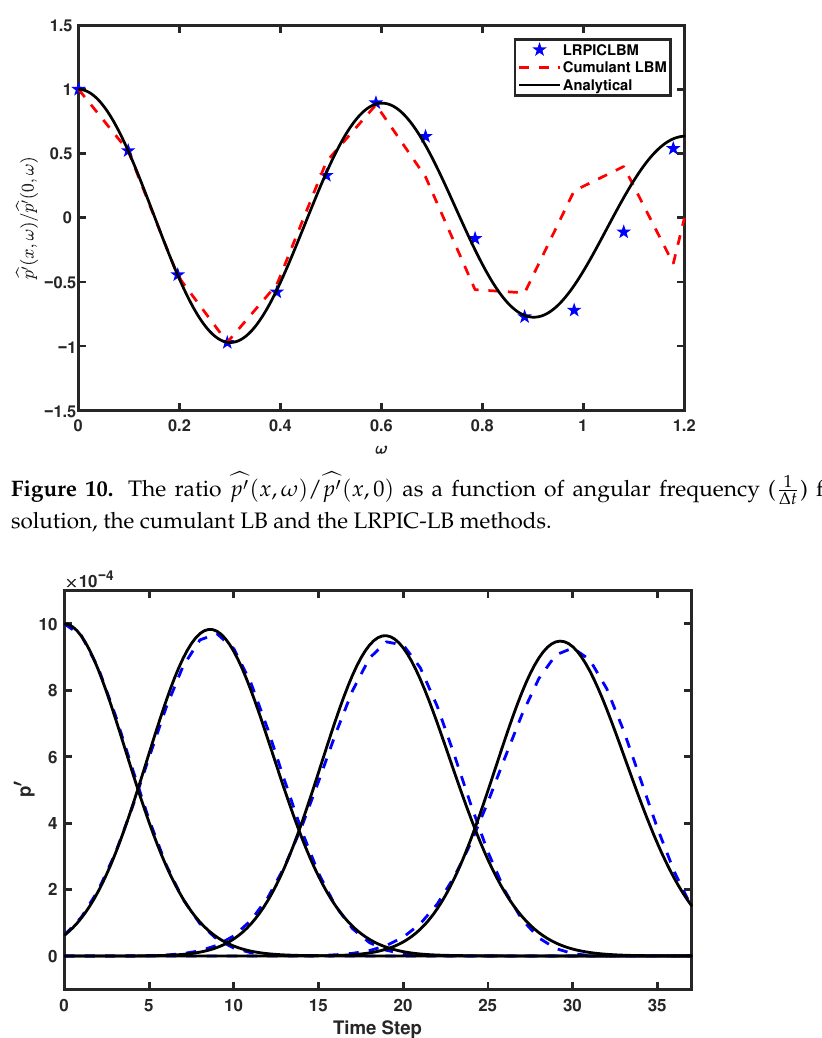
Figure 11. Acoustic pressure ( kg ∆ considering irregular nodal distributions: the cumulant LBM (dashed blue line), LRPIC-LBM (solid black